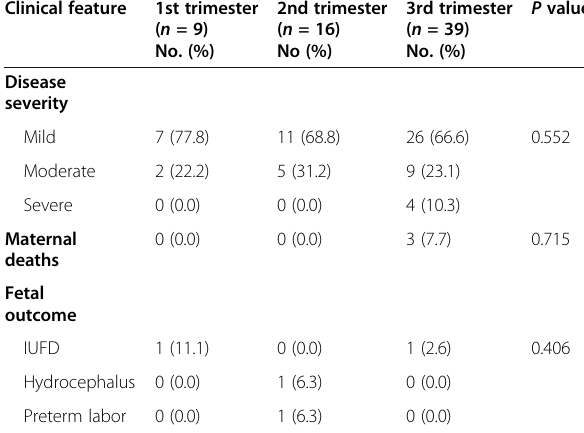
Table 5 Maternofetal clinical features and outcome